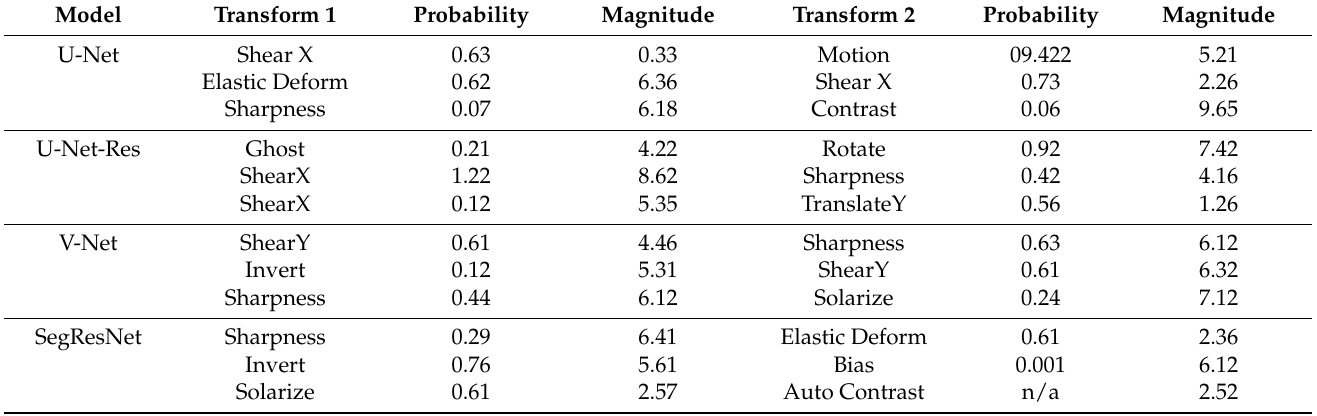
Table A2. Optimal policies selected by our Med-Aug search algorithm with the Fetal MRI dataset.